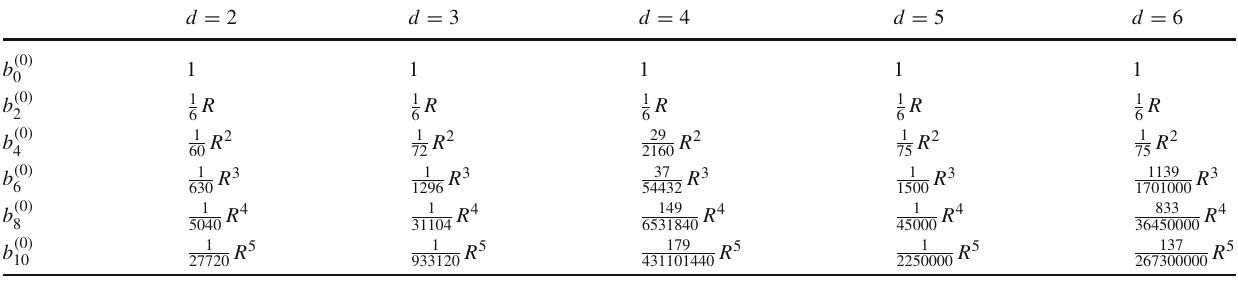
Table 1 The scalar heat kernel coefficients for different integer dimensions and vanishing